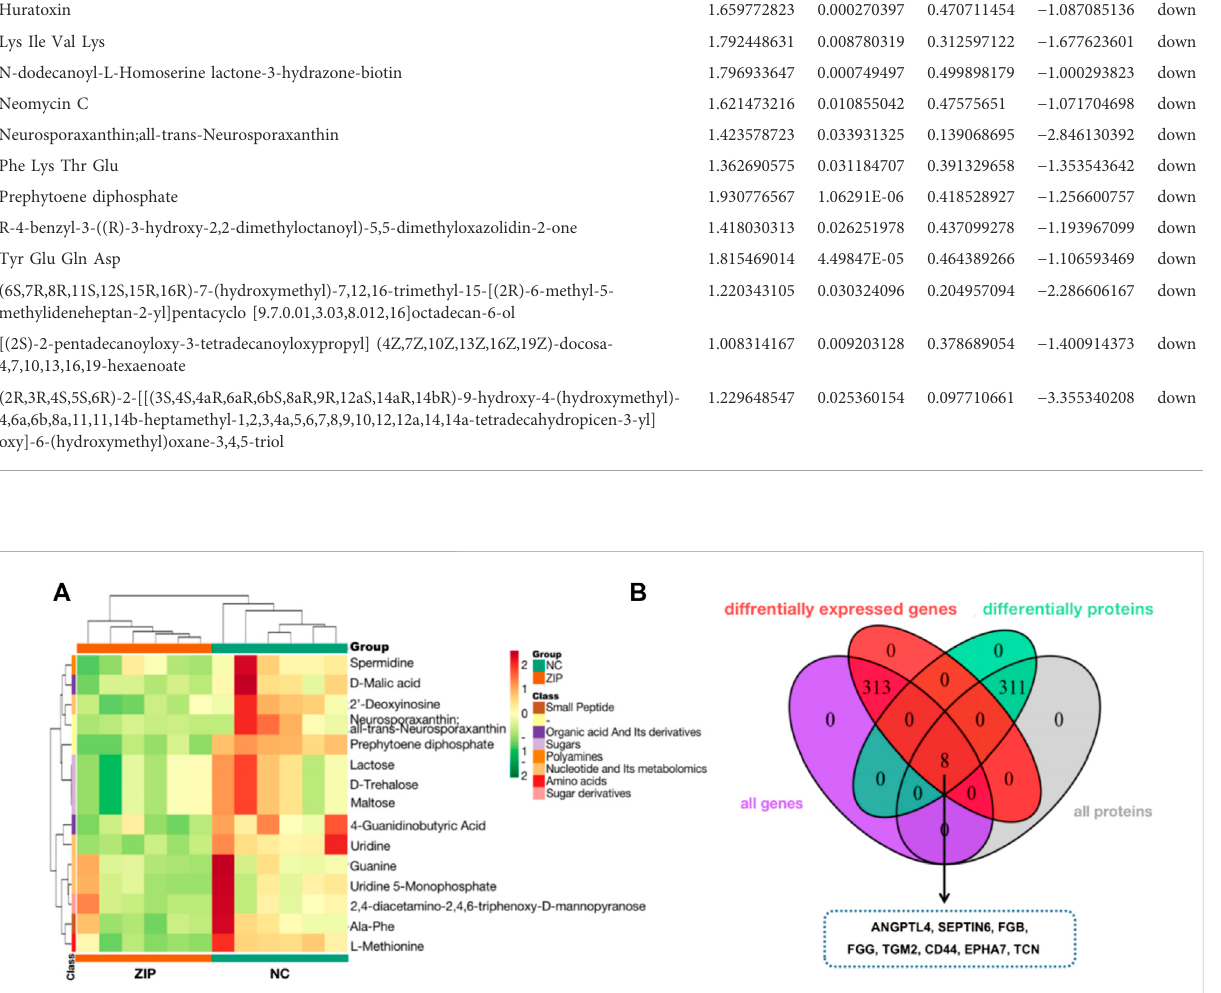
Frontiers in Cell and Developmental